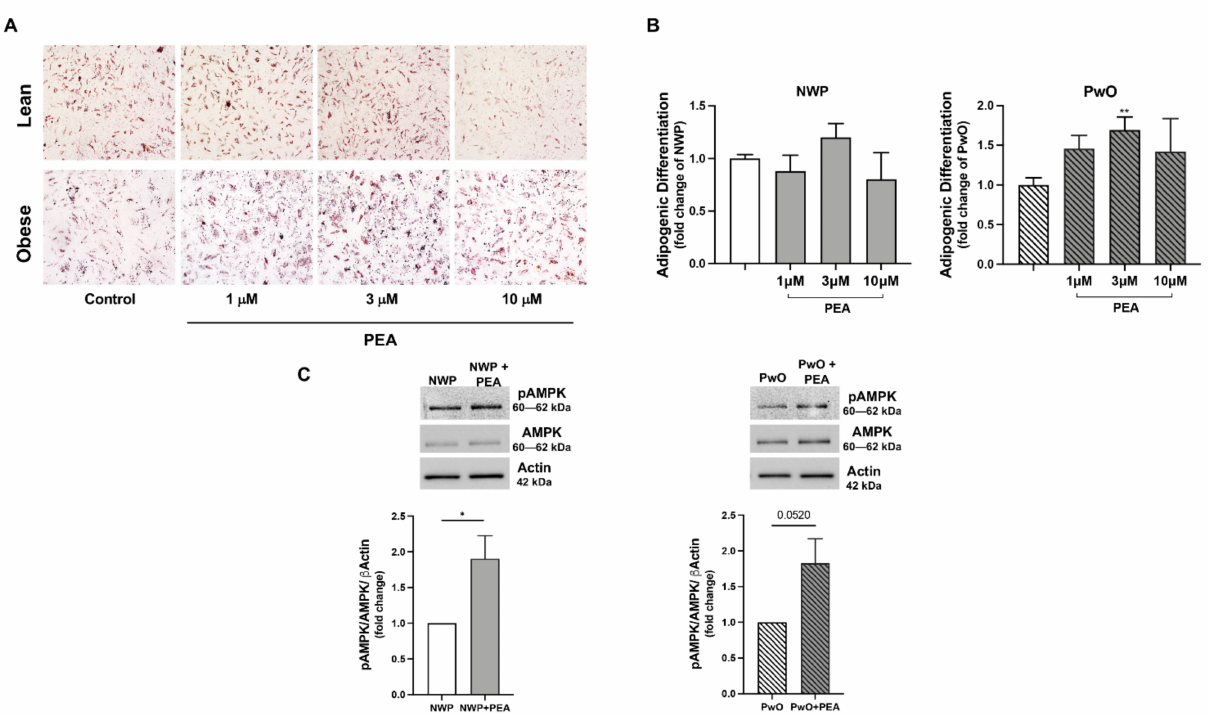
Figure 5. PEA induces adipogenesis in human ASCs. ( A ) Oil Red O staining of differentiated ASCs from NWP and PwO, in the presence or not of PEA (1, 3, and 10 µ M) is reported. ( B ) Their degree of differentiation is also determined. ( C ) The Western blot for phospho-AMPK of cell lysates from NWP and PwO is also performed. Results are shown as mean ± SEM of three different sets of experiments for ASCs cells, respectively. * p < 0.05, ** p < 0.01 significantly differ from